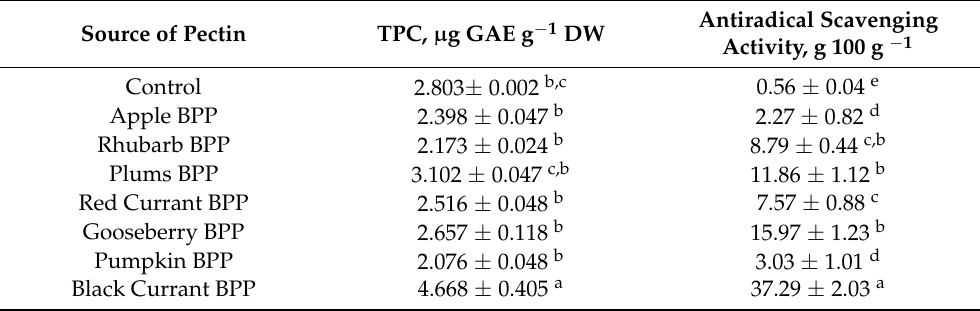
Table 4. The Total Phenolic Content, µ g GAE mL − 1 DW and Antiradical Scavenging activity (DPPH method) of the pectin extracts.